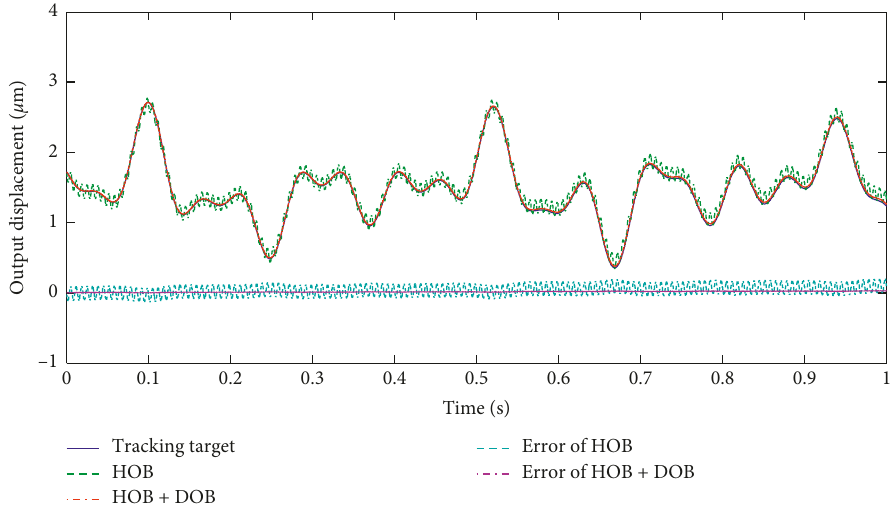
Figure 11: Control results in tracking a nonperiodical target with a sinusoidal